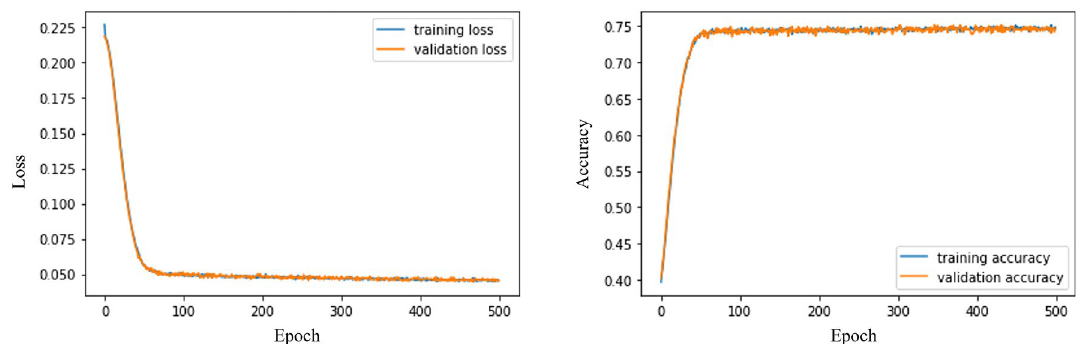
Figure 15. Loss and accuracy of the training and validation of the AE.